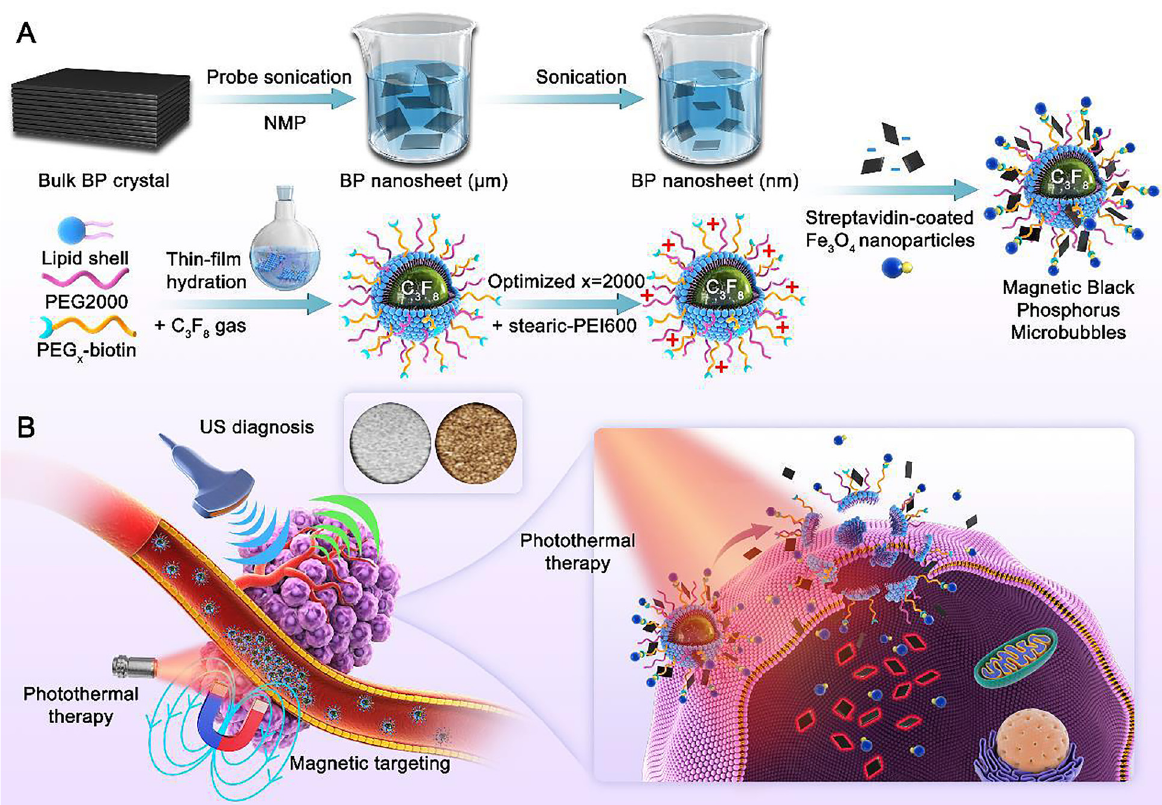
Figure 1E, the BP nanosheets have a broad absorption band covering the ultraviolet to infrared spectral